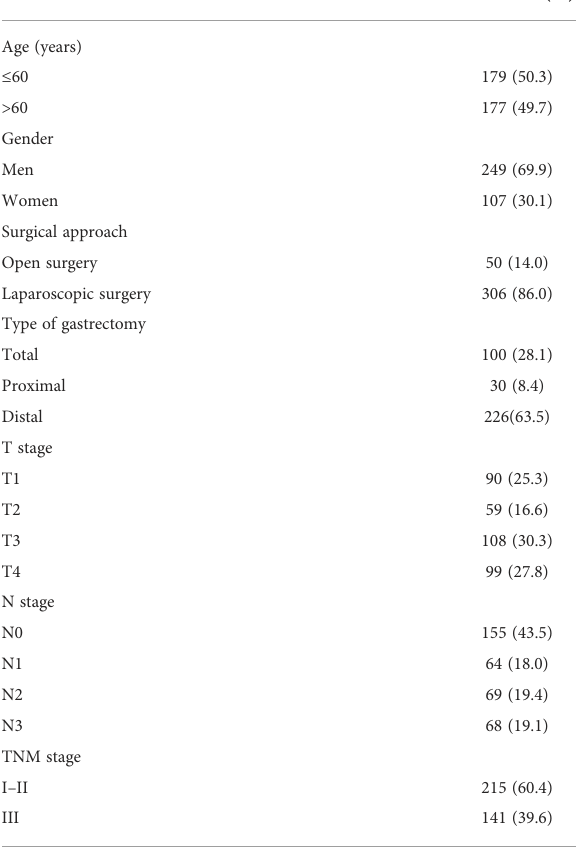
TABLE 1 Demographics and clinical